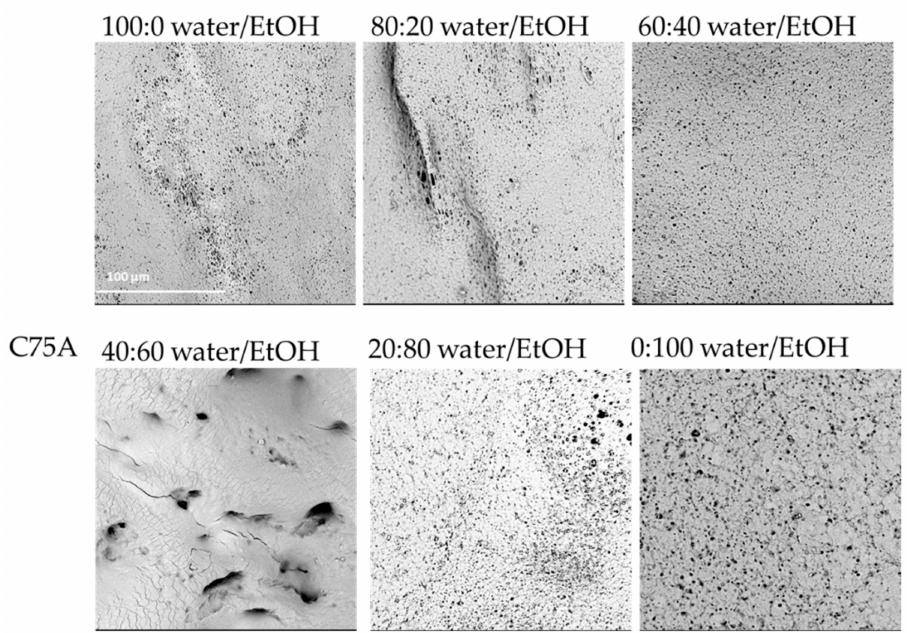
Figure 1. Morphology of internal surface of cylindrical scaffolds obtained from ChronoFlex C75A for different nonsolvent compositions. For 40:60 water/EtOH only the outer surface was observed; scale bar: 100 µ m.